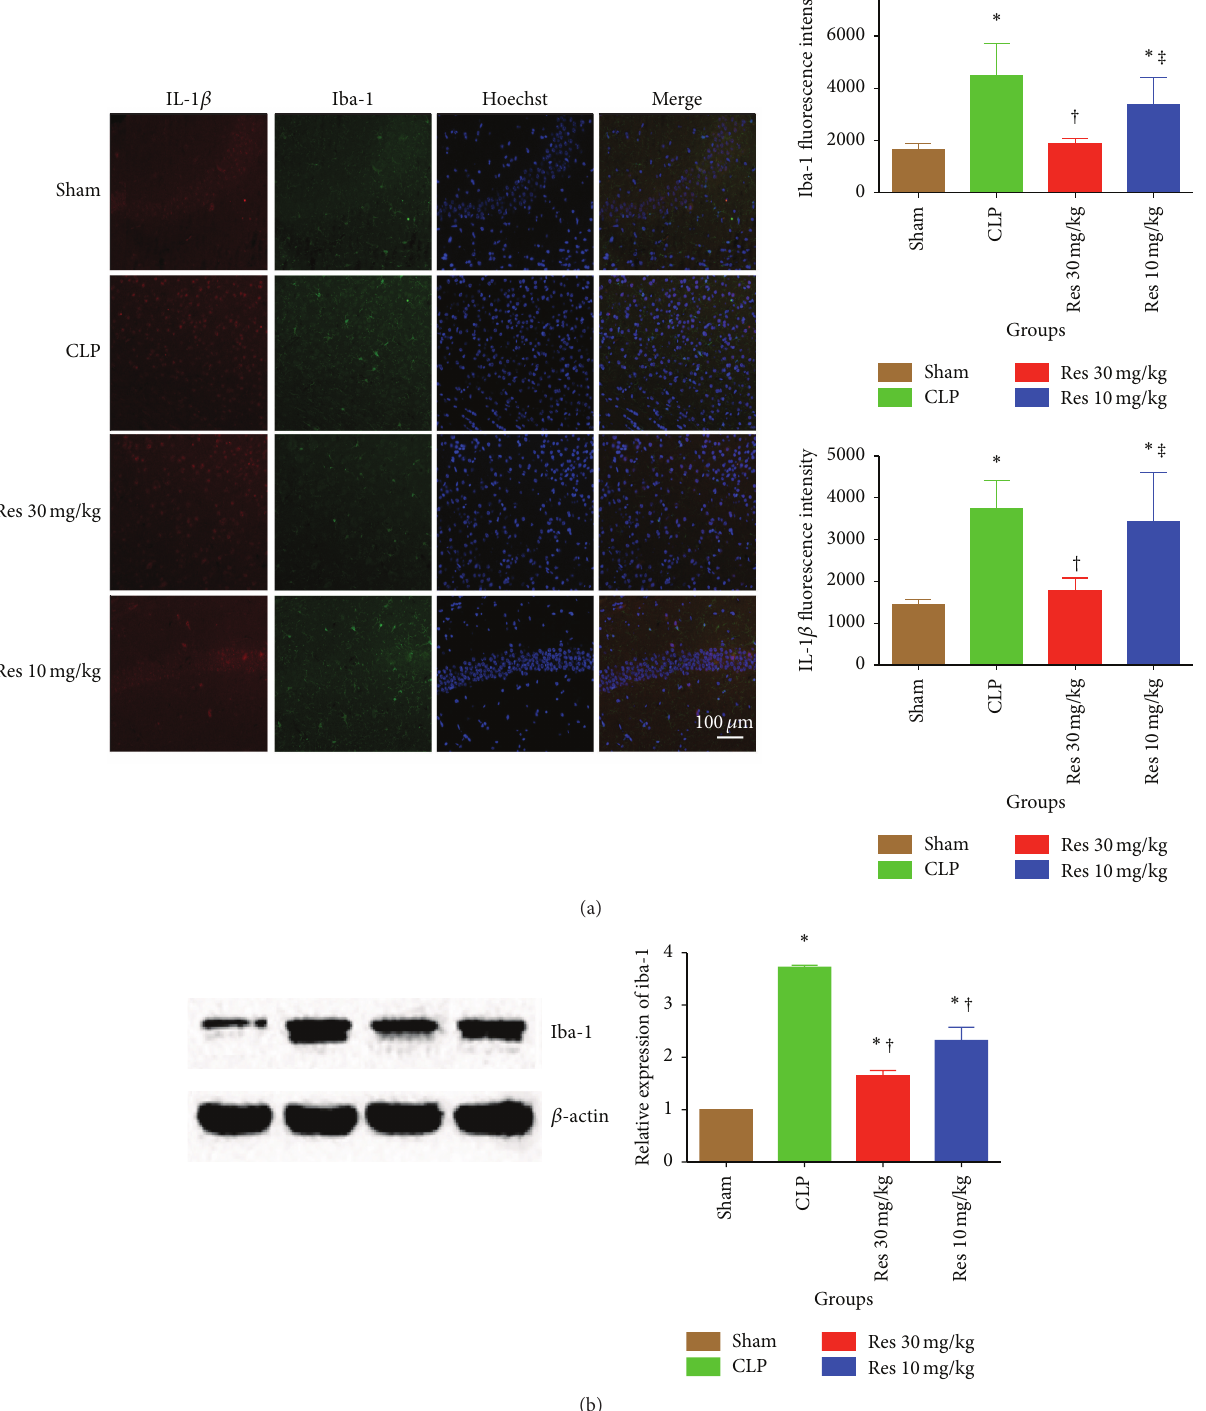
Figure 3: Microglia activation is increased in the hippocampus during SAE but it attenuated in the presence of resveratrol. Resveratrol is able to appropriately modulate the expression and activation of microglia in the hippocampus of CLP treated mice. ∗ 𝑃 < 0.05 compared with Sham group, † 𝑃 < 0.05 compared with CLP group, and ‡ 𝑃 < 0.05 compared with Res1 group, by one-way ANOVA and LSD tests. Bars represent the mean ±